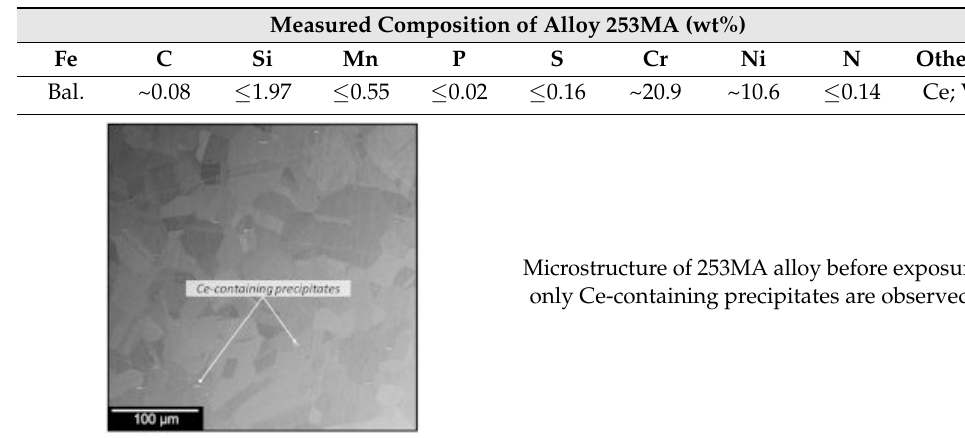
Table 1. Measurement of alloy 253MA in wt% and a corresponding backscatter electron image of the microstructure before exposure. In the lower part of the table: Calculated phase compositions of alloy 253MA at 1050 ◦ C and 800 ◦ C at